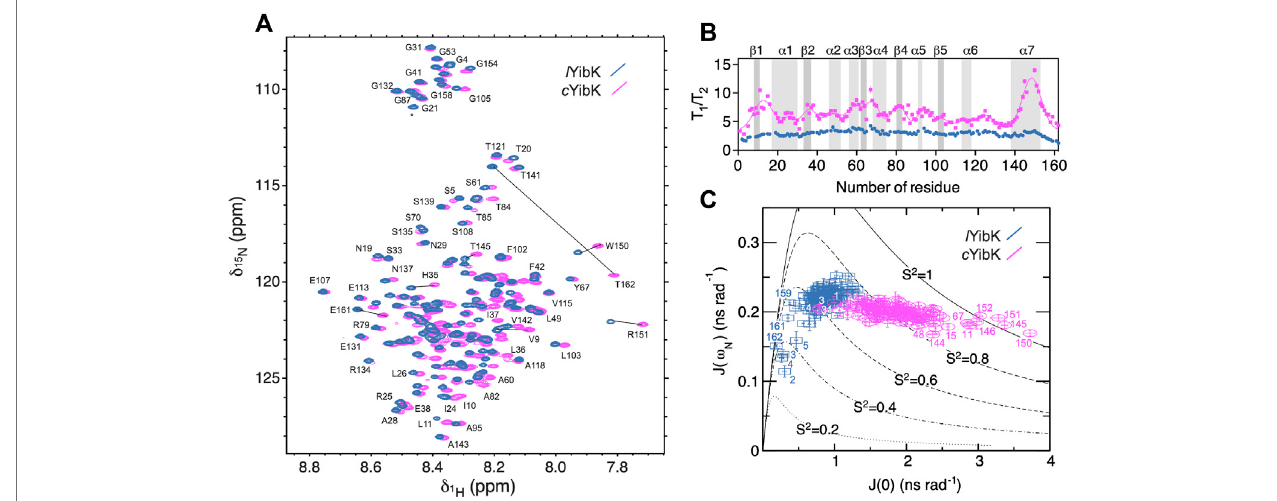
FIGURE 4 | NMR spectroscopy and 15 N spin relaxation analysis of the chemically denatured l YibK and c YibK. (A) Superimposition of the [ 15 N- 1 H] correlation spectraof l YibK(orchidblue)and c YibK(magenta)inthepresenceof7.2 Murea.Thespectrawererecordedata 1 HLarmorfrequencyof850 MHz,and298 K.Residues with large chemical shift differences upon cyclization are indicated by solid lines that connectthe pairs of crosspeaks. (B) T 1 / T 2 ratios of l YibK and c YibK as a function of residue number. T 1 / T 2 ratios of c YibK were fi tted to a sum of multiple Gaussian distributions. Regions that correspond to the β -sheets and α -helices in the native structure are highlighted by dark and light gray, respectively, and are indicated above the panel. (C) Spectral density mapping of the 15 N relaxation data expressed as J ( ω N )asafunctionof J (0).Residuesthatdeviatefromtheclusterdistributionsareindicatedwiththeirresiduenumbers.Theoreticalcurveswiththeassumptionofisotropic motions were calculated for different-order parameters, S (Liu et al., 1980), as indicated. All data points are colored using the same scheme as in ( A ).